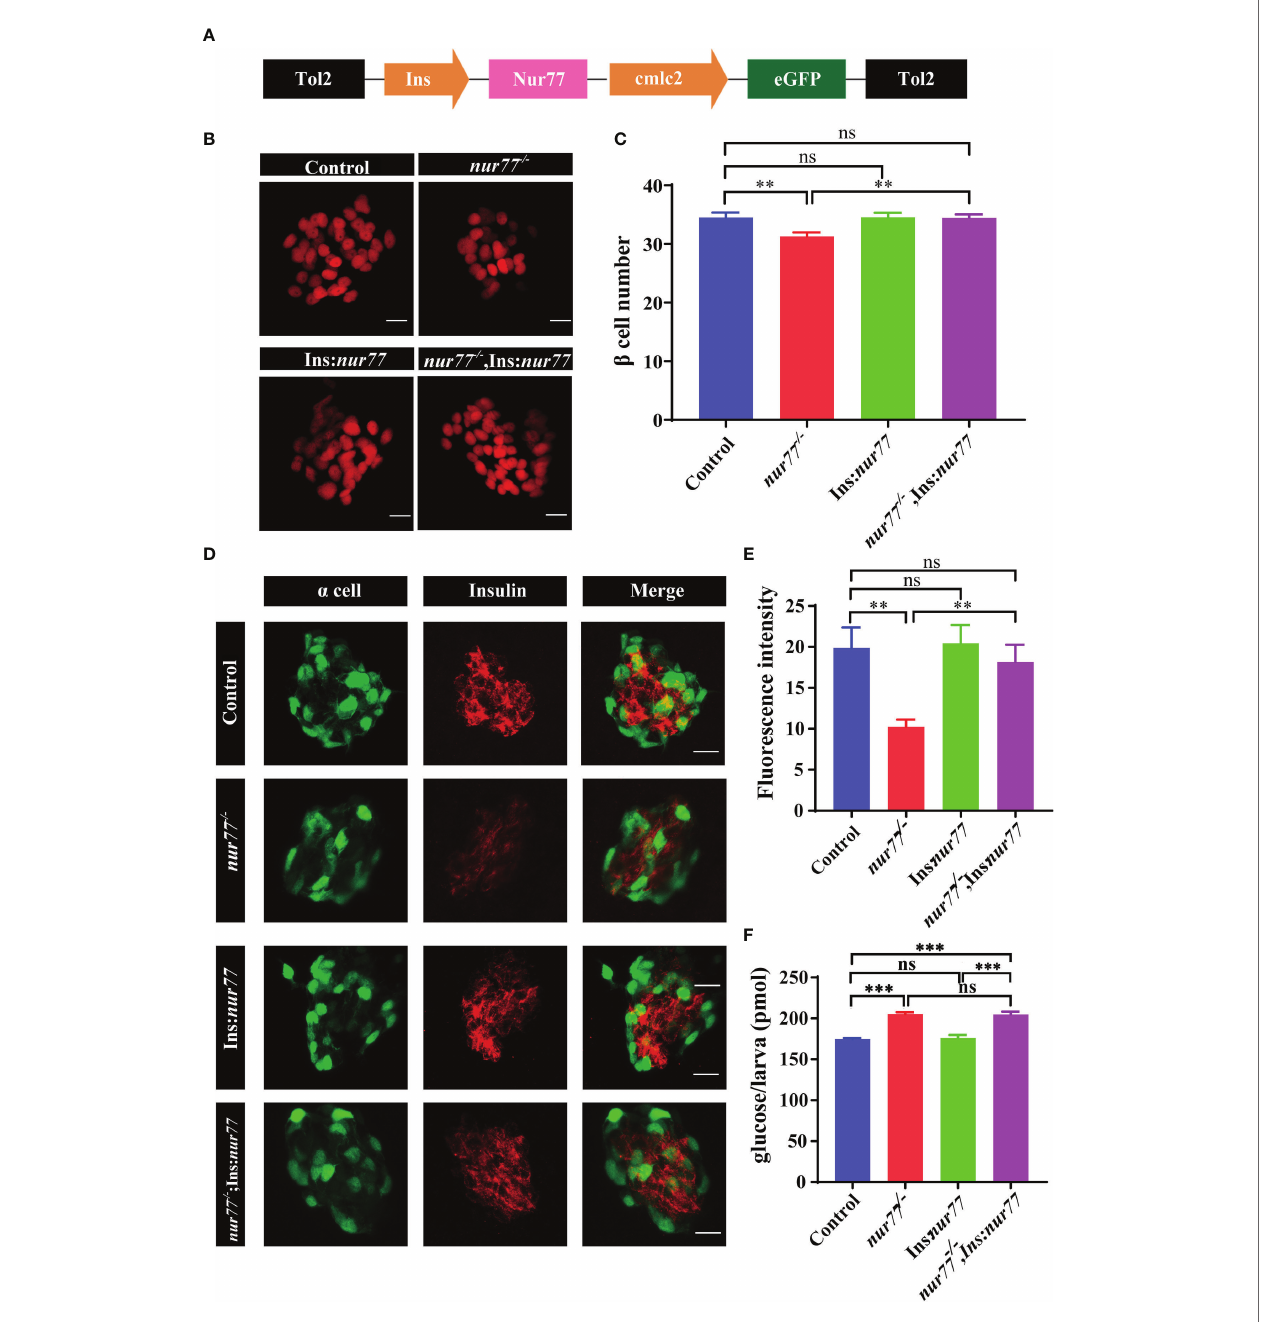
FIGURE 7 | Targeted expression of Nur77 in b cells restored b -cell number and insulin content in zebra fi sh. (A) Schematic representation of the Tg(Ins : Nur77; cmlc2:eGFP) transgenic line and the expression pattern. Expression of Nur77 was controlled by the zebra fi sh insulin promoter with cmlc2 -driven eGFP used as an indication of transgene carriers. (B, C) Representative images (B) and quanti fi cation (C) of b -cell number in Tg(Ins:H2BmCherry) , nur77 − / − ;Tg(Ins:H2BmCherry) , Tg (Ins : Nur77);Tg(Ins:H2BmCherry) and nur77 − / − ; Tg(Ins : Nur77) ; Tg(Ins:H2BmCherry) zebra fi sh larvae. The number of larvae ( n = 20~30). (D, E) Representative images (D) and quanti fi cation (E) of the insulin fl uorescence intensity in b cells from Tg(gcg:eGFP), nur77 − / − ; (gcg:eGFP) , Tg(Ins : Nur77);Tg(gcg:eGFP) and nur77 − / − ; Tg(Ins : Nur77);Tg(gcg:eGFP) zebra fi sh larvae. Tg(gcg:eGFP) was used to indicate the pancreatic a cell, and b cell are indicated with red fl uorescence by immunostaining with insulin antibody ( n = 12~15). (F) The total free glucose contents in Tg(gcg:eGFP) , nur77 − / − ;(gcg:eGFP) , Tg(Ins : Nur77);Tg(gcg:eGFP) and nur77 − / − ; Tg(Ins : Nur77);Tg(gcg:eGFP) zebra fi sh larvae ( n = 3). ns, no signi fi cance; ** p < 0.01, *** p < 0.001 by one-way